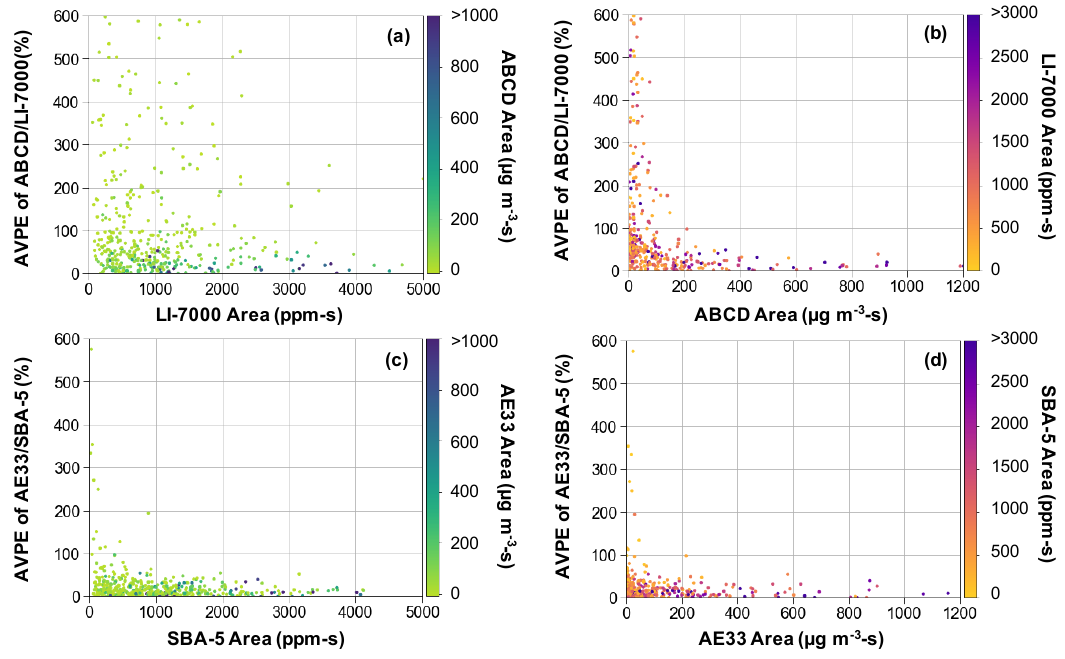
Figure 2. Absolute value percent error (AVPE) of emission factors measured using the ABCD / LI-7000 ( a , b ) and AE33 / SBA-5 ( c , d ) as compared to emission factors measured using the AE33 / LI-7000. Error is plotted versus integrated areas for the: ( a ) LI-7000, ( b ) ABCD, ( c ) SBA-5, and ( d ) AE33. Data shown are from measurements made at the Arterial Road in